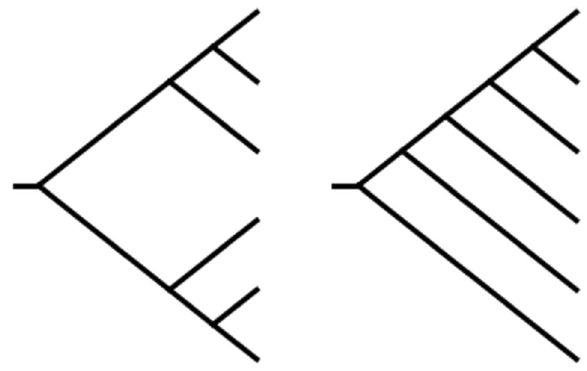
Fig. 1 Balanced (left) and unbalanced phylogenetic trees. The balanced tree on the left-hand side of the fi gure has equal numbers of terminal nodes along each branch, unlike the unbalanced tree on